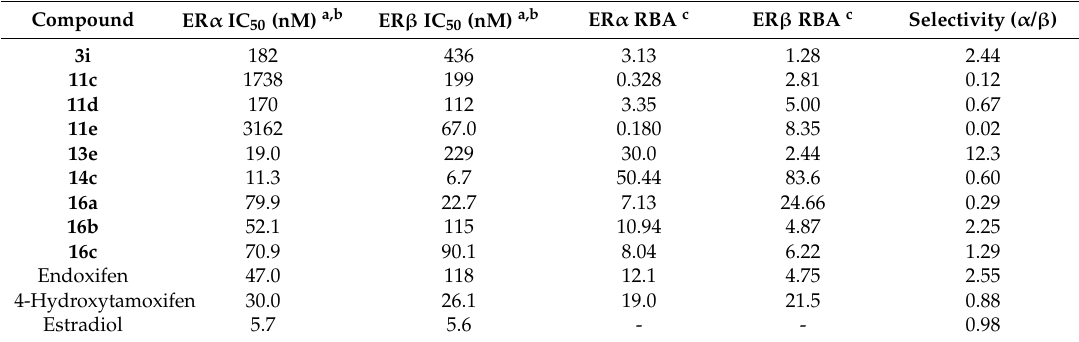
Table 5. Estrogen receptor binding affinities for compounds a